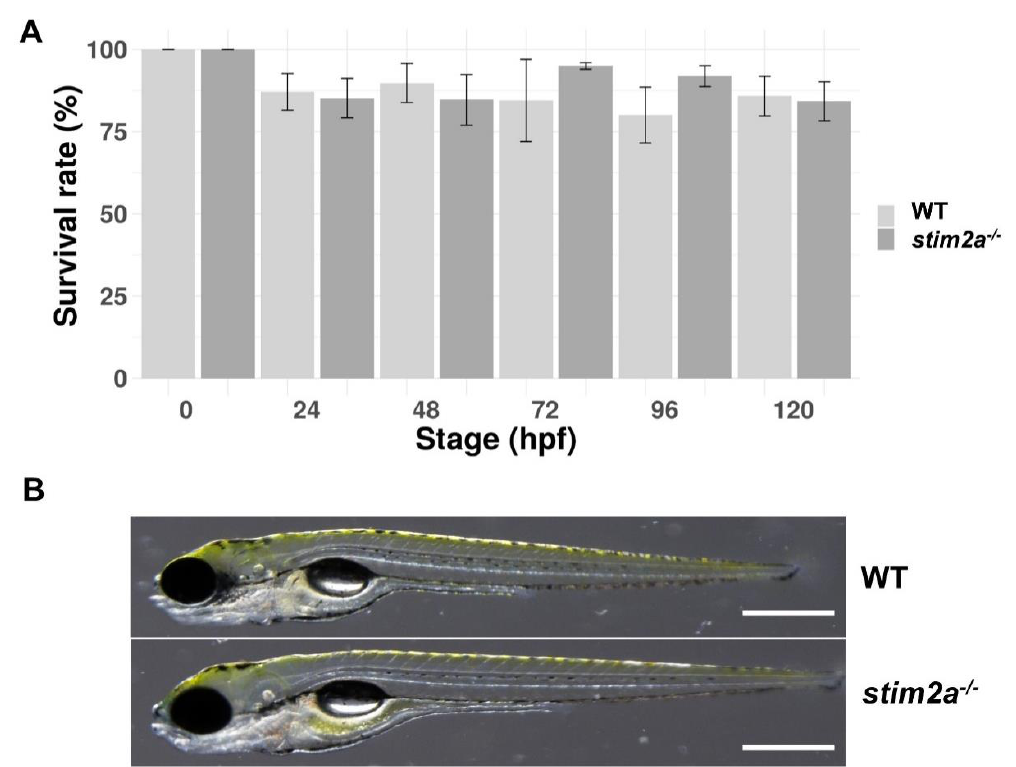
Figure 2. The survival and morphology of stim2a −/− zebrafish did not differ from WT animals. ( A ) Percentage of surviving WT and stim2a −/− zebrafish during the first 120 h of development. The data are expressed as the mean ± SEM. Number of repetitions: 3. Number of larvae for each repetition: 200. ( B ) Side views of stim2a −/− and WT zebrafish at 5 dpf. Scale bars = 500 µm.